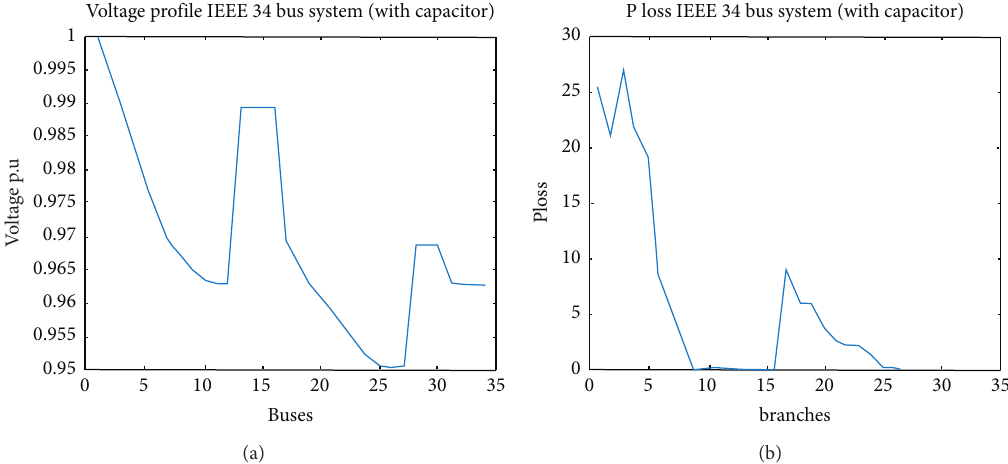
Figure 11: BAT (a) Voltage profile after kVAR compensation IEEE-34 bus system. (b) Power loss after kVAR compensation IEEE- 34 bus